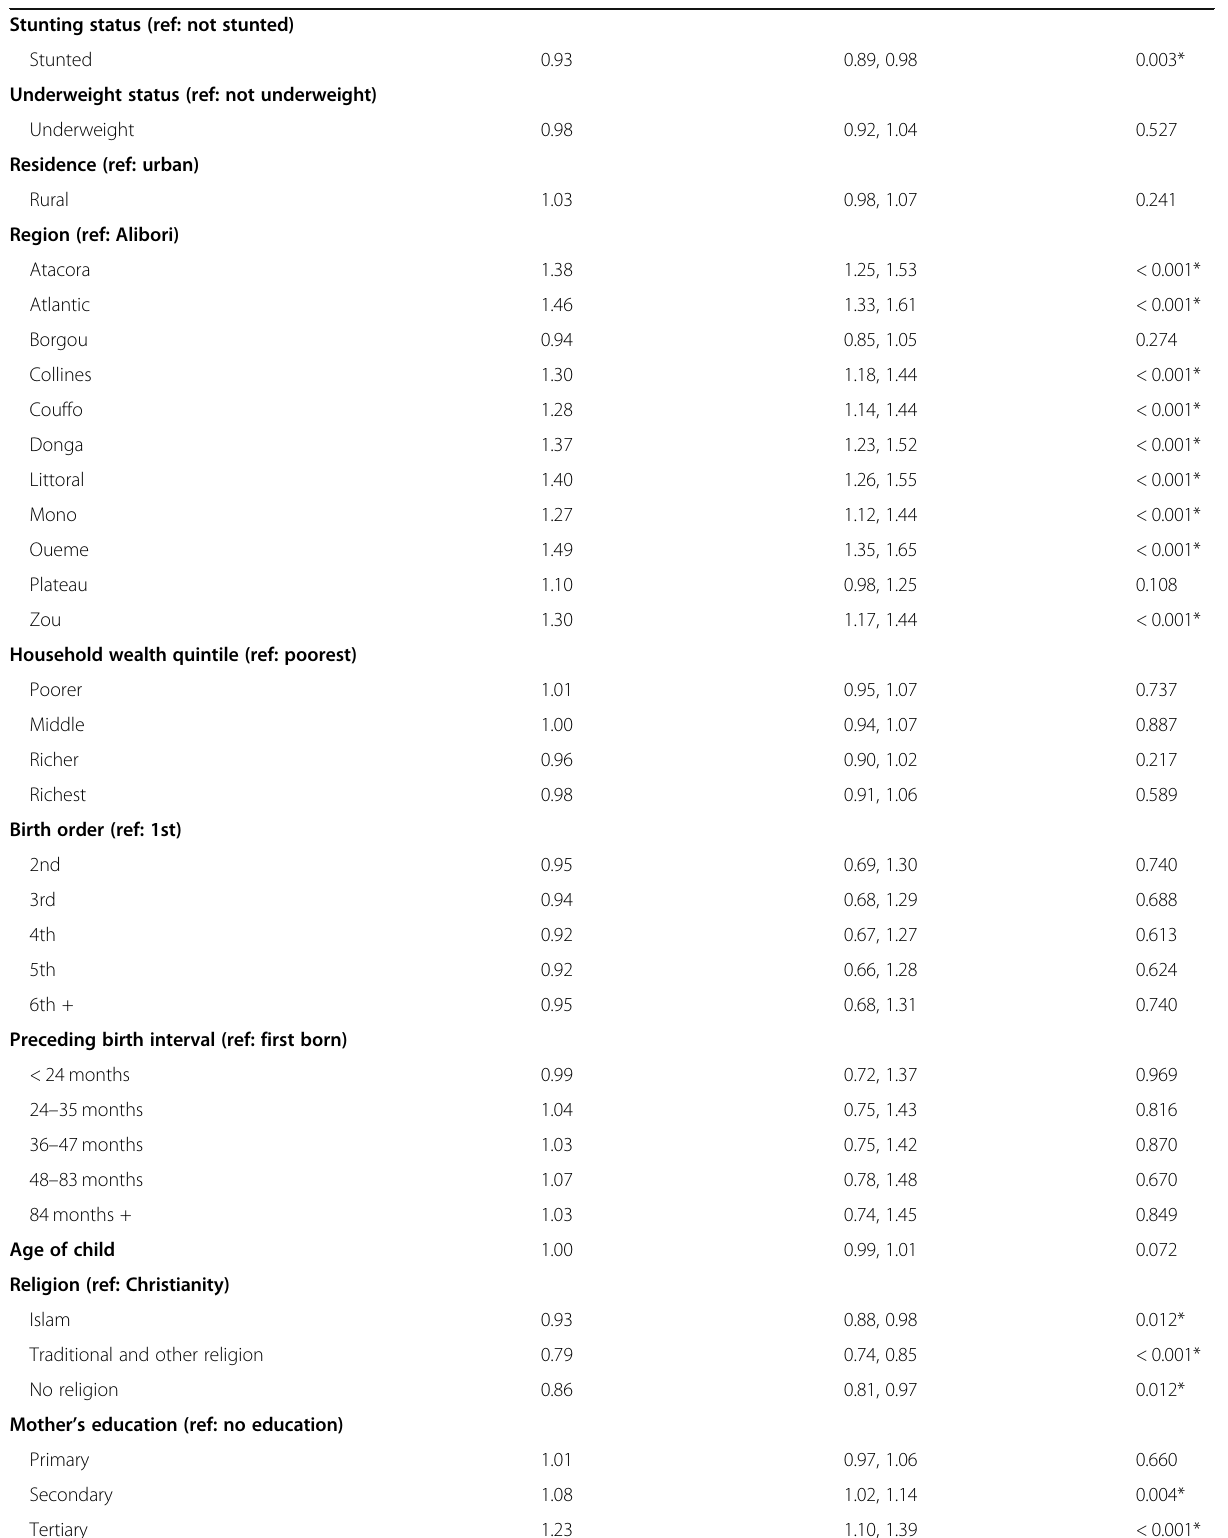
Table 2 Multivariable log binomial model of the factors associated with optimal cognitive development